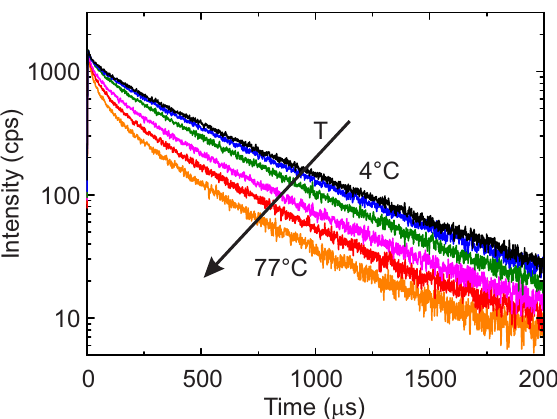
Figure 6. Luminescence intensity decay of the sample with a Mn 4 + doping concentration of 0.40% for temperatures the 4 ◦ C, 12 ◦ C, 29 ◦ C, 45 ◦ C, 61 ◦ C and 77 ◦ C. The direction of the increasing temperatures is also